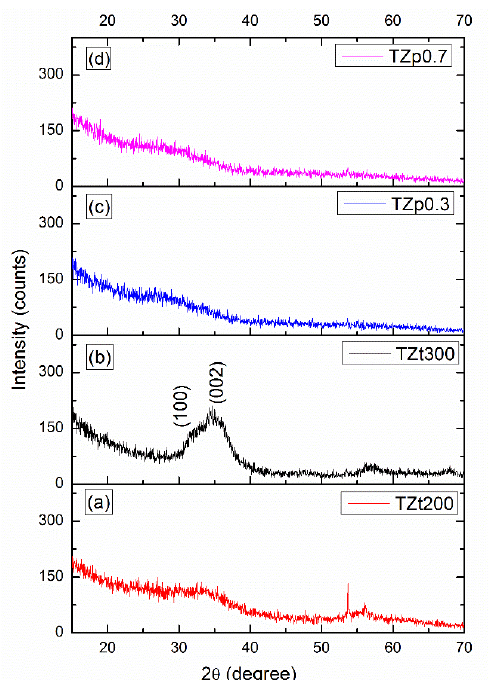
Figure 4. Grazing incidence X-ray fluorescence (GI-XRF) diagrams for Ti, Zn and Si from Ti-doped ZnO thin films with different annealing conditions. ( a ) TA at 200 ℃ , ( b ) TA at 300 ℃ , ( c ) MwPA at 0.3 mbar and ( d ) MwPA at 0.7 mbar.